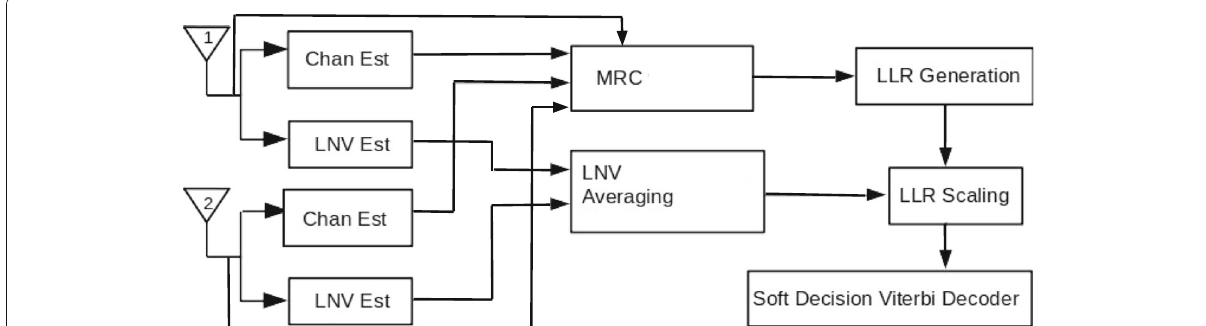
Fig. 8 Schematic of proposed MLSC for 2-antenna WiFi